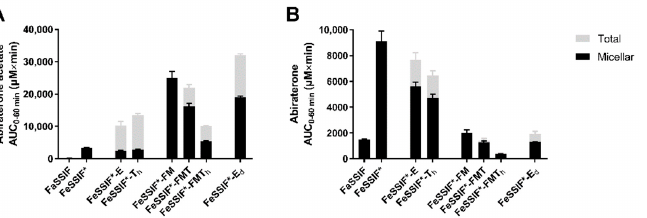
Figure 4. Average AUC 0 ‐ 60 min (± SD) of the total (grey) and micellar (black) perfusate concentration ‐ time profiles of ( A ) abiraterone acetate and ( B ) abiraterone after rat intestinal perfusion of an abiraterone acetate suspension (0.5 mg/mL) in FaSSIF and in simulated fed state media. All media were supplemented with 80 IU/mL esterases, except for FeSSIF* ‐ E d , in which pancreatin (0.83 mg/mL) was used. Results represent mean ± SD (n = 3; F = fatty acids, M = monoglycerides, T = triglycerides, T h = high triglycerides, E = Ensure Plus, E d = digested Ensure Plus).